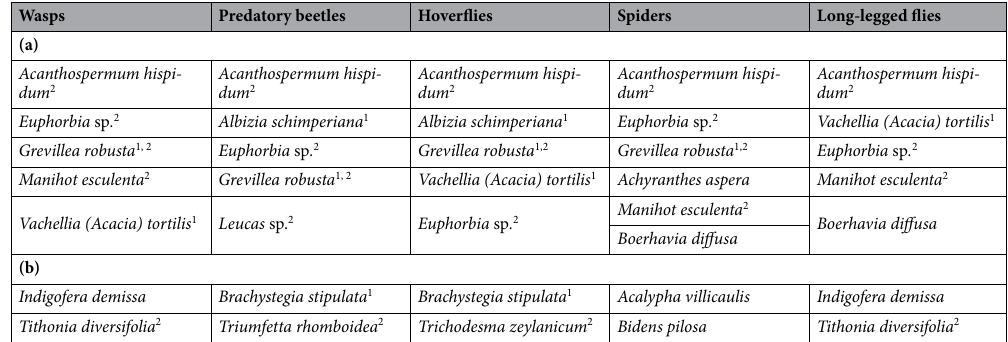
Table 2. The top 5% of non-ubiquitous, non-scarce plant species most regularly associated with some major natural enemy guilds for common bean in (a) Tanzania and (b) Malawi. 1 Tree species. 2 Believed not native to Eastern or Southern